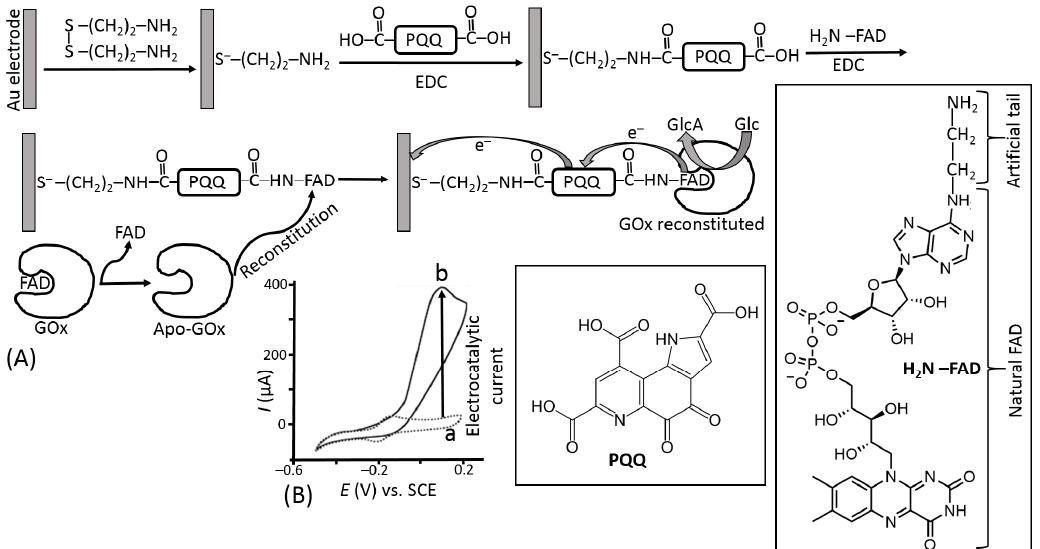
Figure 22. ( A ) Reconstitution of GOx-apo-enzyme (enzyme with the removed active center) on a monolayer composed of an artificial analog of the FAD active centers. PQQ located between the active centers and the electrode surface operates as an intermediate electron-transfer “station” facilitating the electron transport to the electrode surface. ( B ) The cyclic voltammograms show the background current in the absence of glucose (a) and in the presence of glucose, 80 mM (b), potential scan rate, 5 mV s − 1 . Abbreviations used: FAD—flavin adenine dinucleotide, PQQ—pyrroloquinoline quinone, EDC—1-ethyl-3-(3-dimethylaminopropyl)carbodiimide (reagent used in the covalent immobilization process).